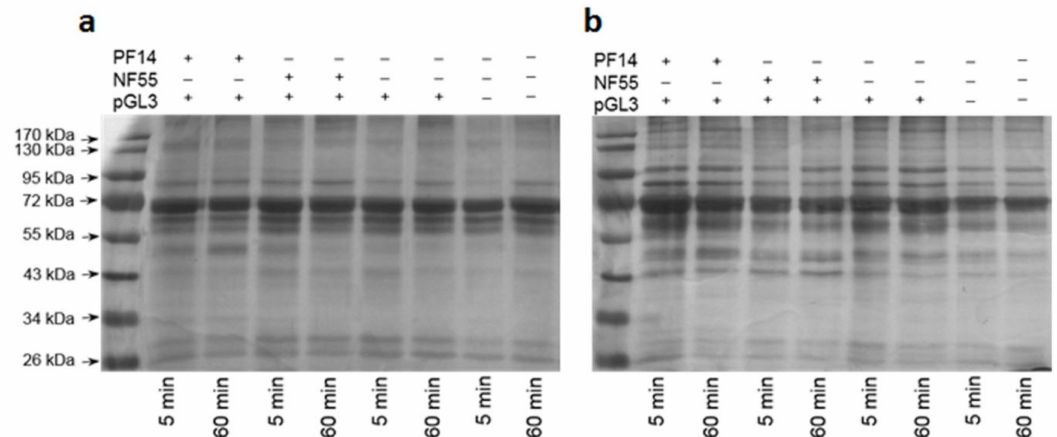
Figure 1. Adsorption of proteins on the CPP-plasmid DNA nanoparticles. CPP-pGL3 nanoparticles or pGL3 alone were immobilised on streptavidin-superparamagnetic beads and incubated in foetal bovine serum ( a ) or murine serum ( b ) for 5 or 60 min at room temperature. After pull-down of formed complexes, proteins were separated on 9% acrylamide gel and visualised by silver staining. One representative of three independent experiments is